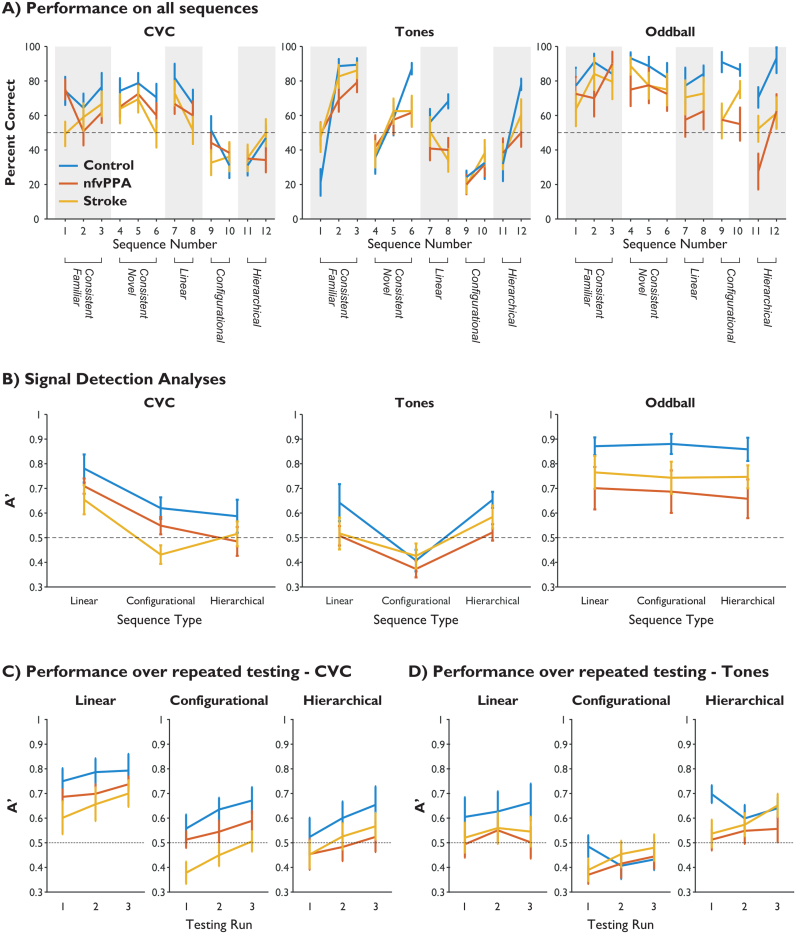
Group performance on sequence identification. Dashed lines represent chance performance. Error bars represent group-wise standard error of the mean. Controls are in blue, nfvPPA in red and stroke in orange. A) Proportion of correct responses for each testing sequence by group and task. Sequences 1–3 were consistent with the grammar and familiar from the exposure phase, while 4–6 were consistent and novel. Sequences 7–12 contained violations of the types indicated (see Table 2). B) Discriminability of each rule type by group for each language type. C) Overall discriminability by group and run number for the CVC language (improving performance by run represents learning over time). D) Overall discriminability by group and run number for the tone language. (For interpretation of the references to color in this figure legend, the reader is referred to the web version of this article.)